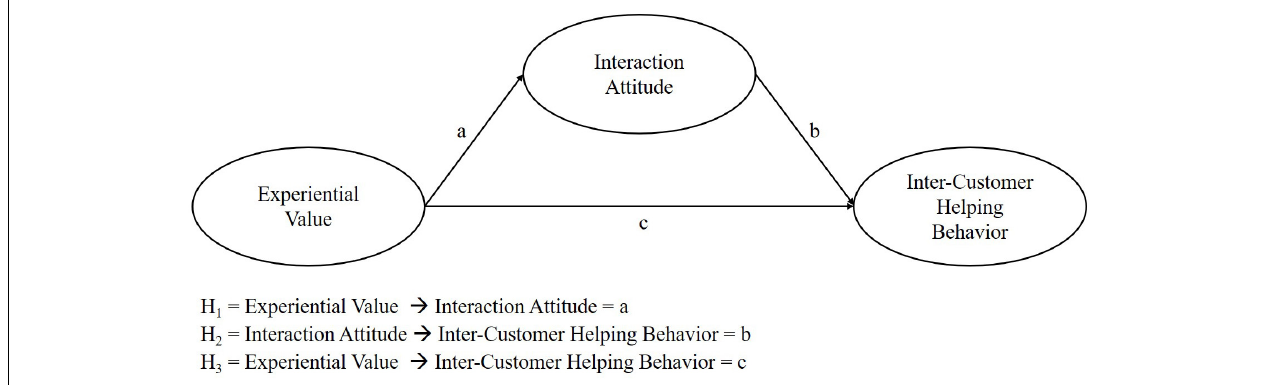
FIGURE 1 | Conceptual